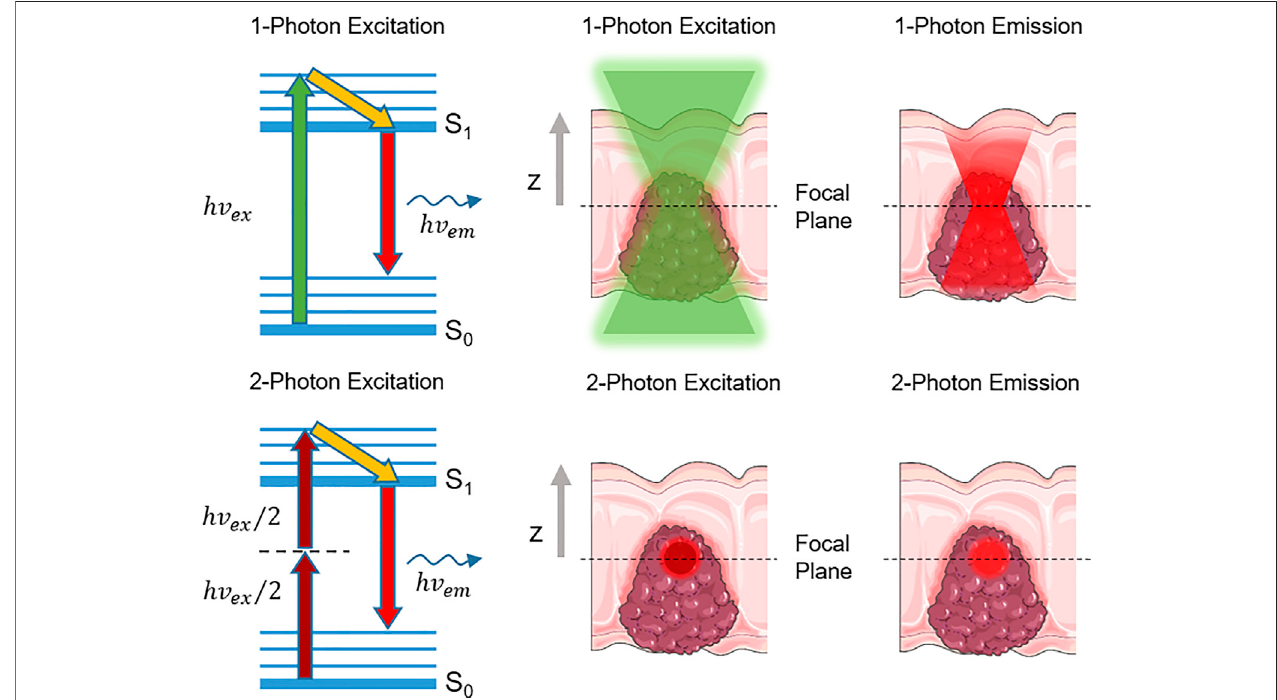
FIGURE 2 | (Left) Simpli fi ed Jablonski diagram illustrating the double-photon absorption and single-photon emission involved in 1PA vs. 2PA excitation (Middle) Demonstratesthequadraticexcitationthatarisesin2PAvs.1PA,duetotherequirementoftwophotonshavingtoarrivesimultaneouslyatasampletoresultinexcitation (Right) The resulting tissue is capable of producing fl uorescence emission due to the location of the excitation photons in 2PA vs. 1PA, resulting in more focused, high- resolution images in 2PA fl uorescence imaging.